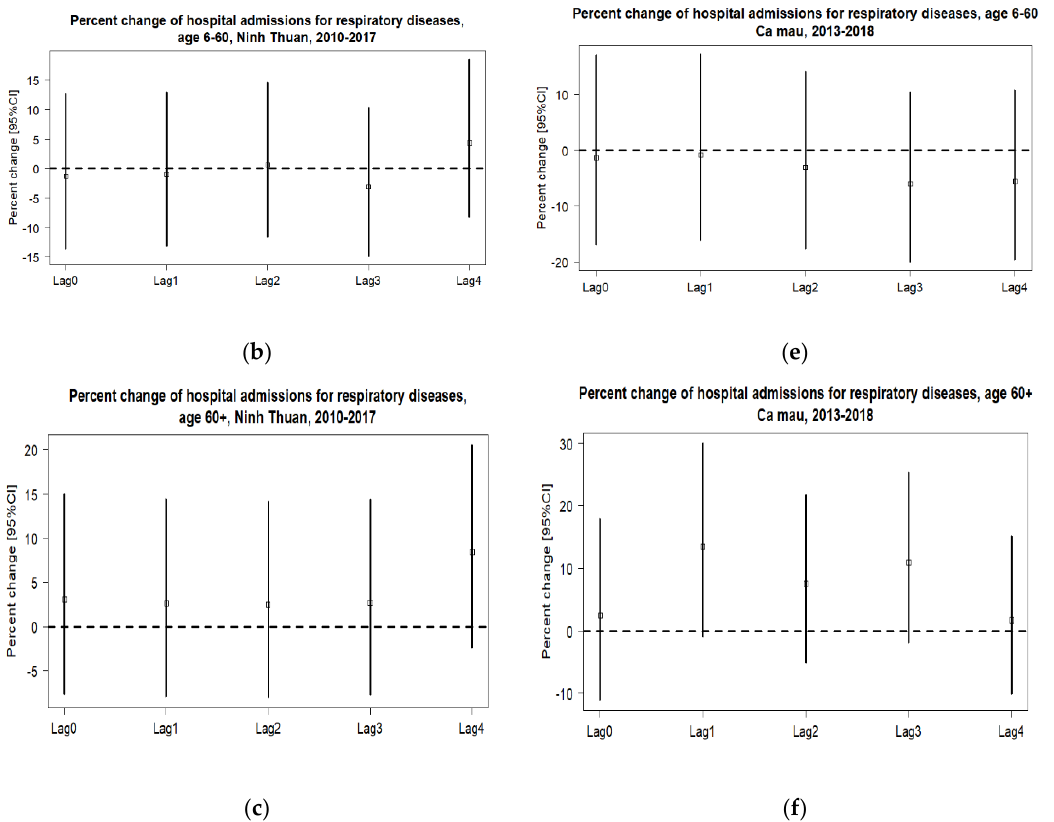
Figure 1. The lag distribution of the associations between heatwave and hospital admissions for respiratory diseases in Ninh Thuan (( a ) among those aged 6 ‐ 60; ( b ) among those 60 and above) and Ca Mau (( c ) among thosed aged 6 ‐ 60; ( d ) among those 60 and above). Note: Percent changes in the odds of daily hospital admissions were estimated from Quasi ‐ Poisson regression models, adjusting for long ‐ term trends and seasonal variation, day of the week, holiday, and mean humidity (natural cubic spline with four degrees of freedom). While hospital data in Ninh Thuan are from 1 January 2010 to 31 December 2017, hospital data in Ca Mau are from 31 May 2013 to 31 July 2018. Bar: 95% confidence